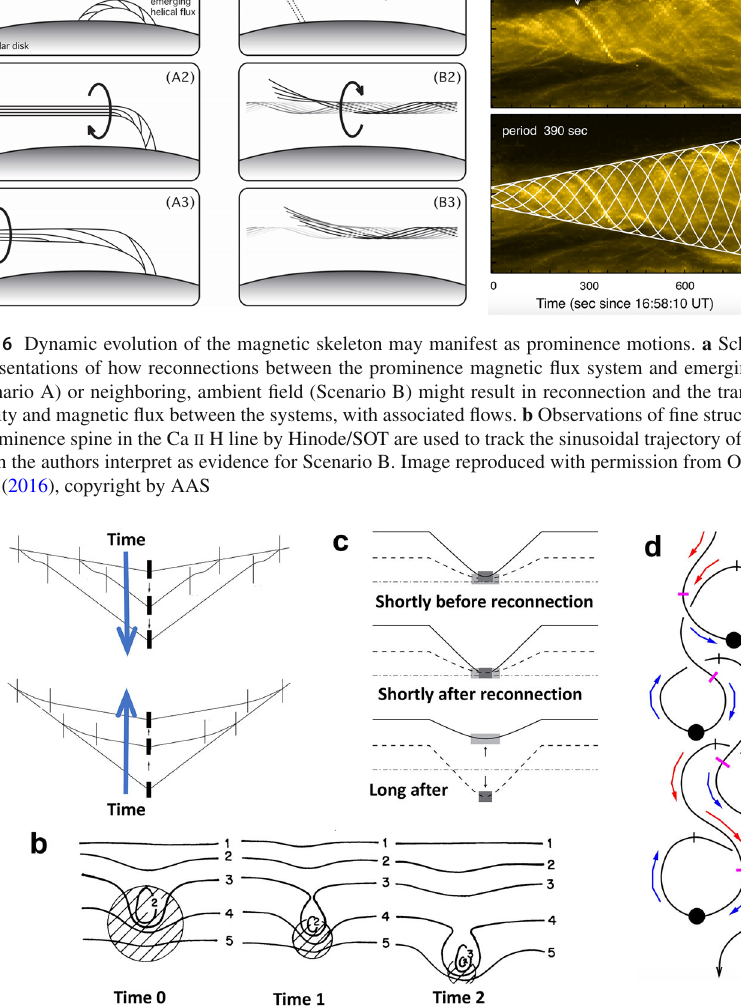
Fig. 17 Vertical flows in prominence sheets are possible even when the local magnetic field orientation is horizontal. a Constant-speed descent (top) or ascent (bottom) may arise in KS-type prominence sheets that are in local equilibrium but out of equilibrium with their supporting magnetic structure. From Low and Petrie (2005). b Gravity acting on prominence plasma may lead to sagging field lines that reconnect to form a descending knot of closed field. From Lerche and Low (1980). c Reconnections at tangential discontinuities may pass a parcel of prominence mass downward across neighboring field lines whose dips collectively form a vertical structure. From Chae (2010); see also Petrie and Low (2005). d Tangled magnetic field lines may possess sufficient horizontal magnetic field to support prominence mass against free fall. From van Ballegooijen and Cranmer (2010). Images reproduced with permission, a , c , d copyright by AAS; b copyright by